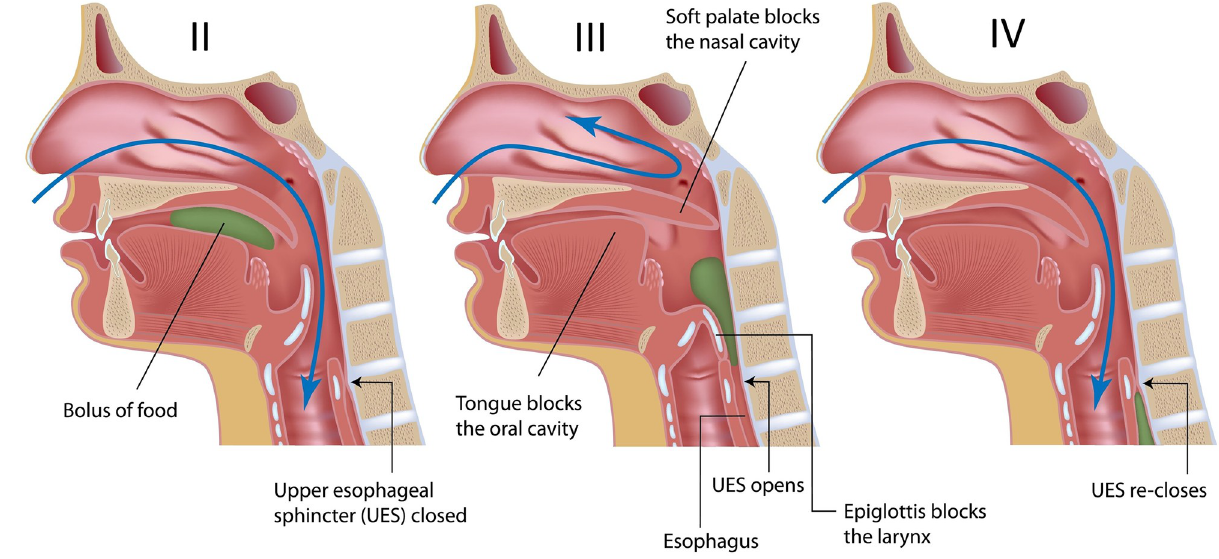
Fig 1. Schematic representation of phases II, III and IV of human